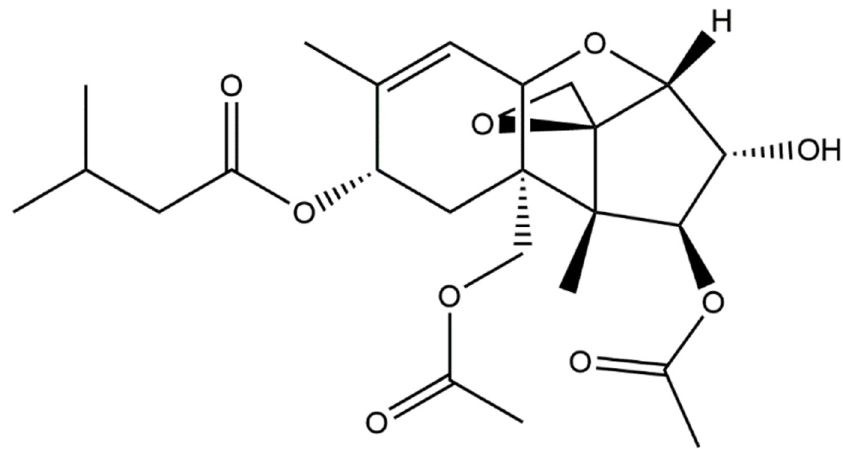
Figure 1. The structure of T-2 toxin.